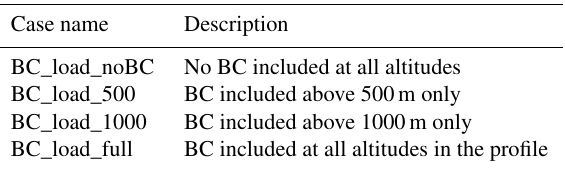
Table 5. Table detailing the outline of each of the four simulations for the third case study focusing on the impact of changing BC load- ing in different aerosol layers (Case